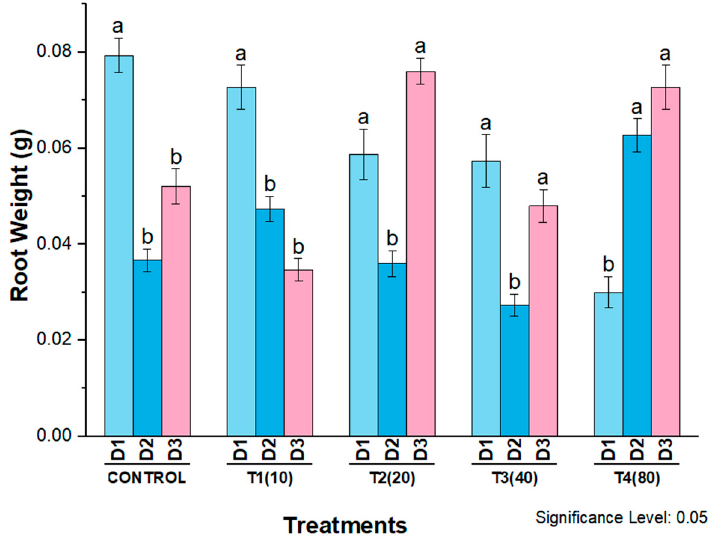
Figure 13. Root weight of wheat cultivar Bakhtawar in response to 10, 20, 40, and 80 mg/L of AgNPs. All values are the average of 3 replicates, the error bars represent the standard errors of the means, and different letters indicate the significant difference at p = 0.05 by LSD test in each group.